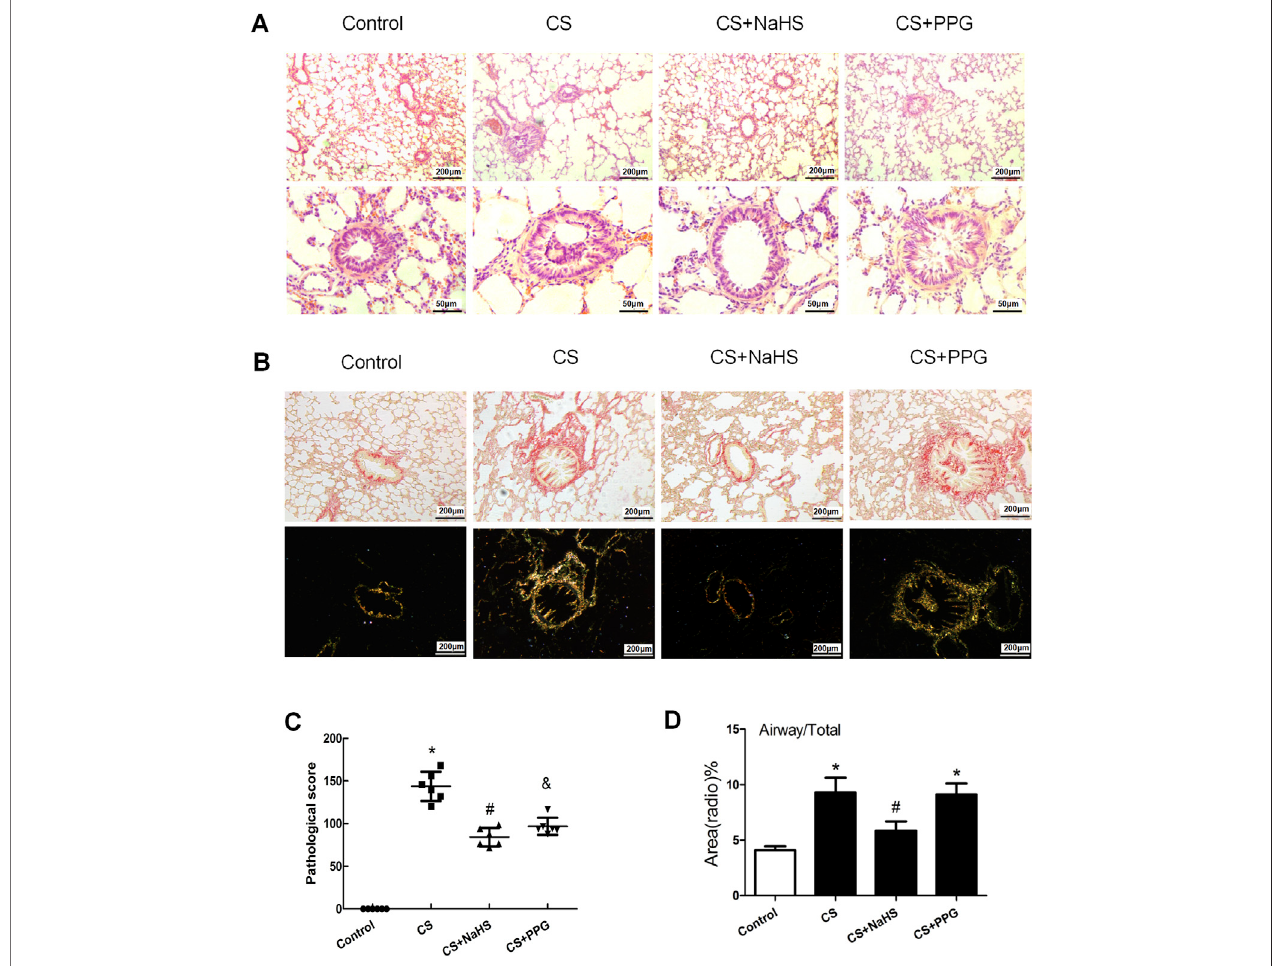
FIGURE2| Changesinlungpathologyandsmallairway fi brosisinrats. (A) Lungtissuesectionswerestainedwithhematoxylinandeosinandexaminedunderlight microscopy. Original magni fi cation ×100 and ×400. (B) Lung tissue sections were stained with Picrosirius red staining and examined on bright fi eld microscopy (above panels) and polarization microscopy (down panels). Original magni fi cation ×100. (C) Airway obstruction, necrotic epithelium, goblet metaplasia, in fl ammatory cell in fi